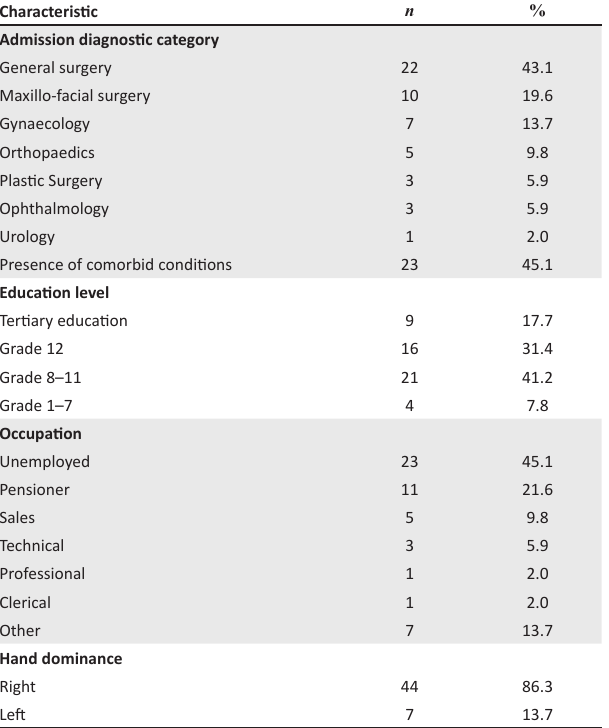
TABLE 1: Population characteristics.